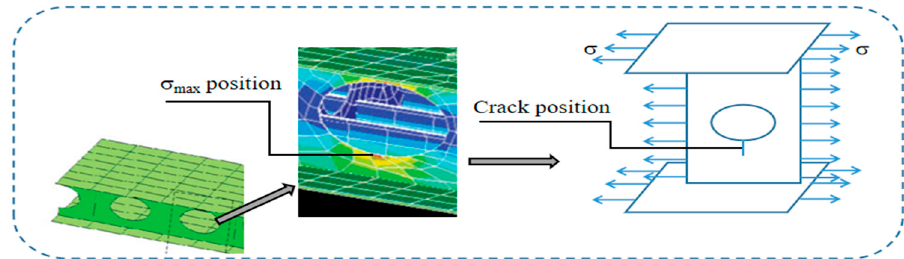
Figure 6. A typical double deck structure of the pipe-laying ship and its hot-spot position (crack- prone position) [17].